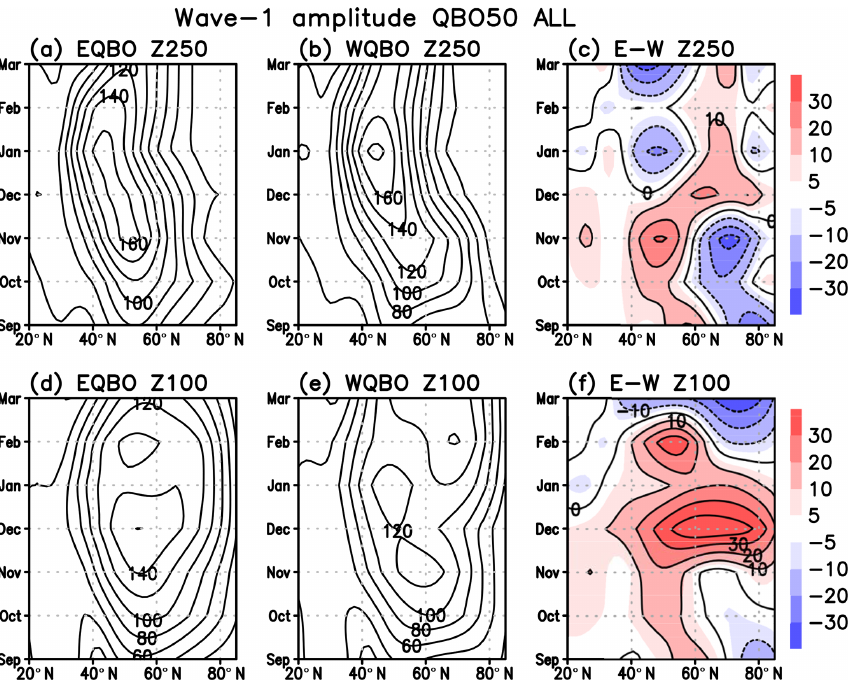
Figure 17. Latitude–month plots of observed wave-1 amplitude. (a) EQBO composite at 250hPa. (b) WQBO composite at 250hPa. (c) Dif- ference between EQBO and WQBO. (d–f) Same as in panels (a–c) but for 100hPa. Contours in panels (a) , (b) , (d) and (e) are 20m, and those in panels (c) and (f) are